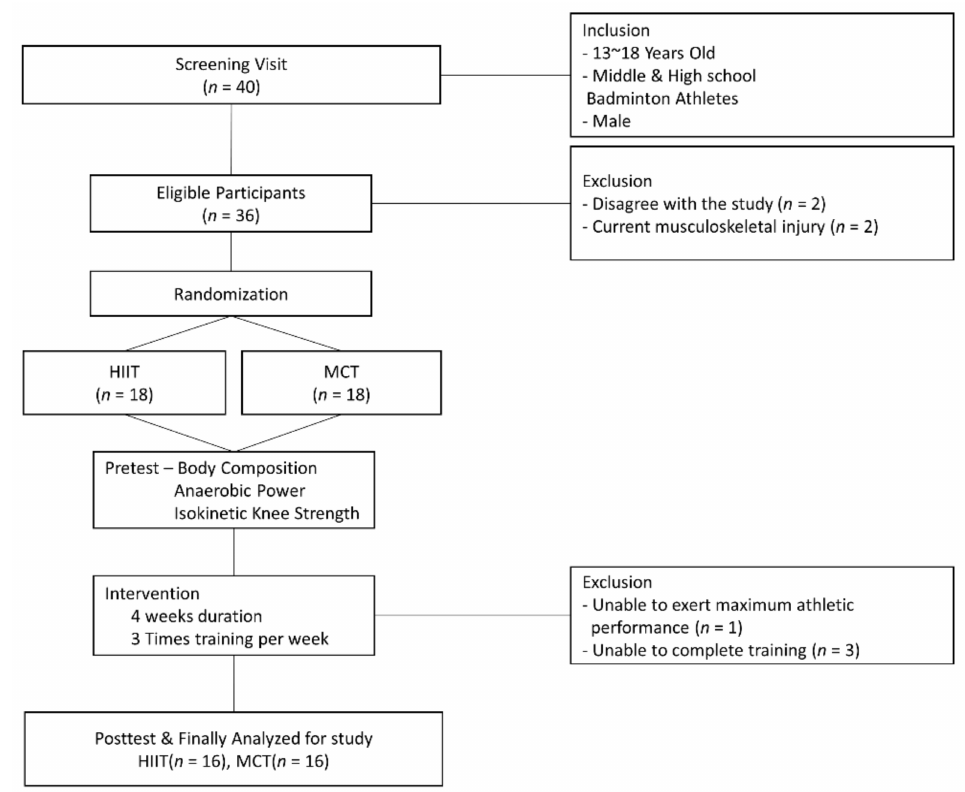
Figure 1. The design of Study; HIIT, high-intensity interval training; MCT, moderate continuous